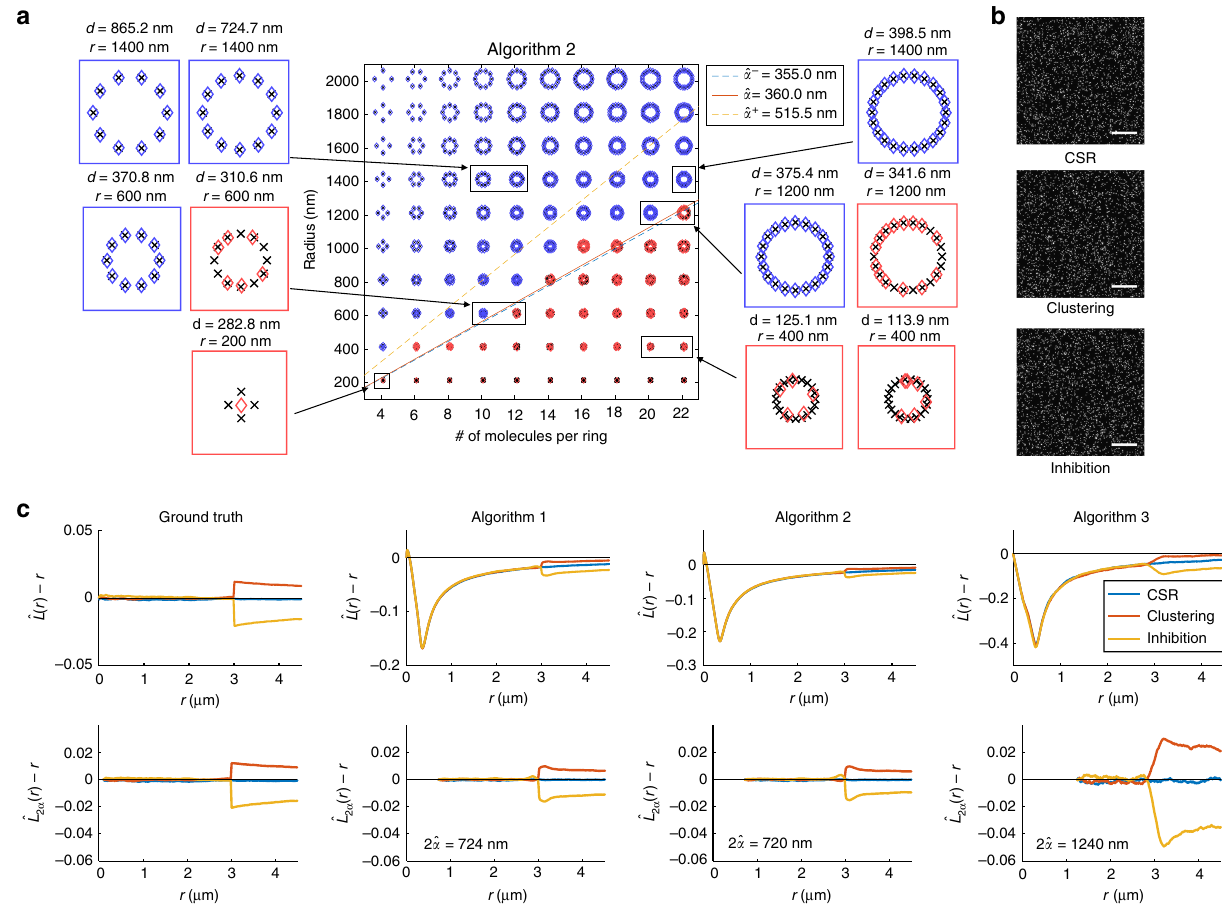
Fig. 3 Application of algorithmic resolution limit to localization microscopy. a Application of the algorithmic resolution limit to the analysis of nonstochastic data illustrated using images of deterministic structures. Each structure consists of single molecules positioned evenly around the edge of a ring (crosses). Localizations were obtained by analyzing the image corresponding to each structure using Algorithm 2 (diamonds). Localizations corresponding to structures where all constituent molecules were accurately identi fi ed and localized to within 10 nm of the true location are shown in blue. Localizations corresponding to structures where one or more molecules were either not identi fi ed or where the localization deviated by more than 10 nm from the true location are shown in red. Magni fi ed views of some structures are shown with the radius of the corresponding ring ( r ) and the distance between adjacent molecules on the edge of the ring ( d ) indicated above each magni fi ed view. All molecules of structures where the spacing between adjacent molecules is greater than the algorithmic resolution limit of Algorithm 2 are accurately identi fi ed and localized to within 10 nm of the true location. The solid line corresponding to ^ α ¼ 360nm indicates the algorithmic resolution limit for Algorithm 2. The dashed lines on either side of the solid line indicate the bootstrapped 80% con fi dence interval for the estimate of α (see Supplementary Note 9). Results obtained by analyzing the same images using other approaches are provided in Supplementary Figure 12. b Sample images from three datasets that were analyzed to obtain the results shown in ( c ). The three datasets were generated with the following spatial distribution of molecules (see Methods): completely spatially random (CSR) distribution, random distribution with a preferred spacing ranging from 2990 to 3010 nm between molecules (clustering), and random distribution with molecules avoiding spacings between 2990 to 3010 nm of each other (inhibition). Scale bar = 10 μ m. c ^ L ð r Þ (cid:2) r plot compared to the corresponding resolution-corrected ^ L r Þ (cid:2) r plot calculated based on localizations obtained by analyzing the three datasets illustrated in ( b ). For each analysis approach, the value 2 α ð corresponding to 2 ^ α indicated in Fig. 2d is used to calculate ^ L 2 α ð r Þ . Results show that deviations from 0 in the ^ L ð r Þ (cid:2) r plot are corrected for completely spatially random distributions of locations when the algorithmic resolution limit is taken into account. Results for distributions with clustering or inhibition spacings between molecules still show corresponding deviations from 0 in the corrected ^ L 2 α ð r Þ (cid:2) r